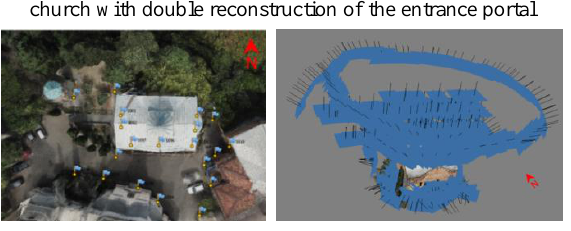
Figure 9. left: Control point overview of the evaluation in PhotoScan; right: Overview of the image data from image flight and terrestrial images after the image orientation in PhotoScan